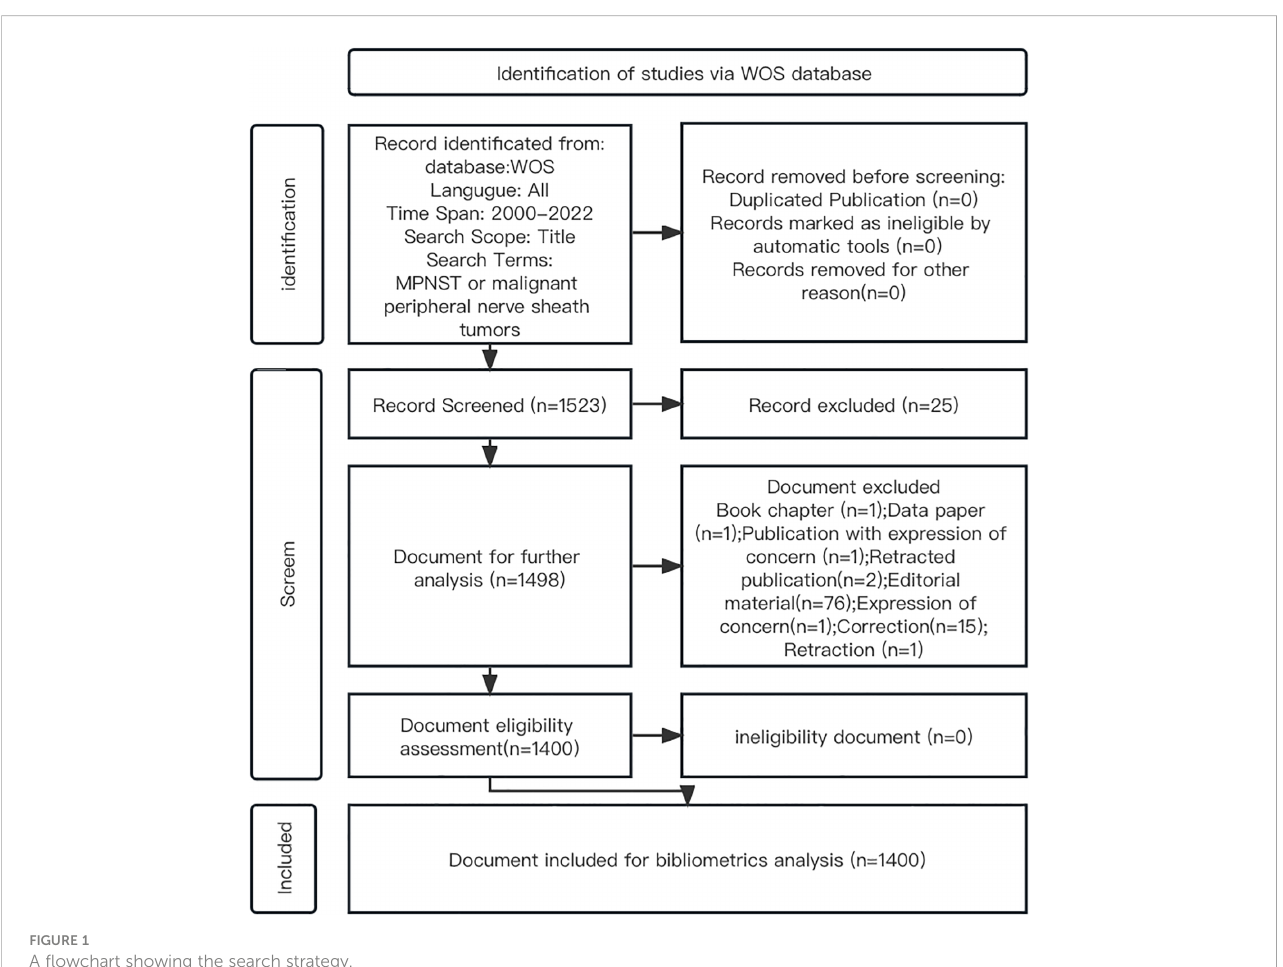
FIGURE 1 A fl owchart showing the search